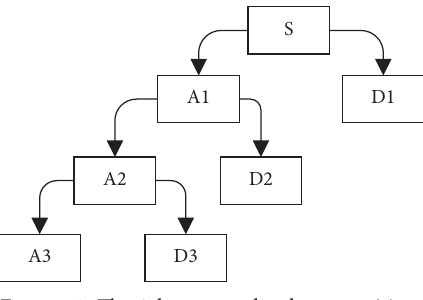
Figure 1: The 3-layer wavelet